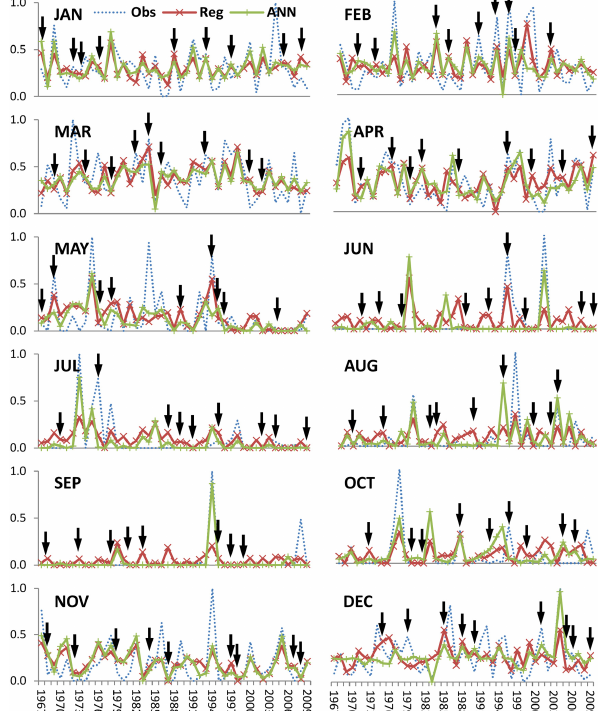
Figure 2. Comparisons between observations and ANN model re- sults as well as regression model results: the arrows indicate the chosen data for validation (normalized precipitations are shown on the vertical